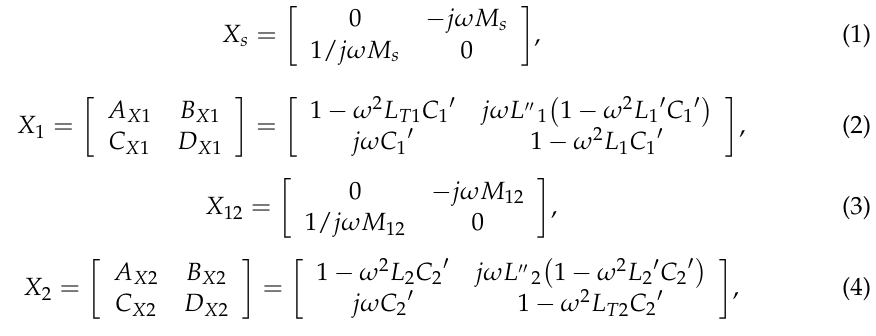
Figure 2. Modified equivalent circuit obtained by applying T-transformation to each coupling unit. Z 1 , Z 2 , Z 3 , Z 4 , Z 5 , and Z 6 are the impedances looking into the load Z L at each coupling unit. X S , X 1 , X 12 , X 2 , and X L denote the transmission (ABCD) matrices of each